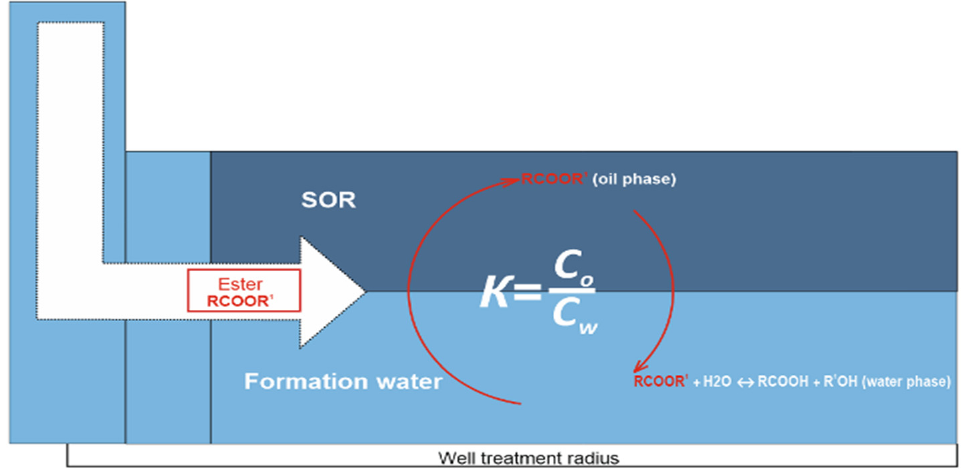
Figure 4. Schematic representation of the reactive-extraction process of primary tracer.